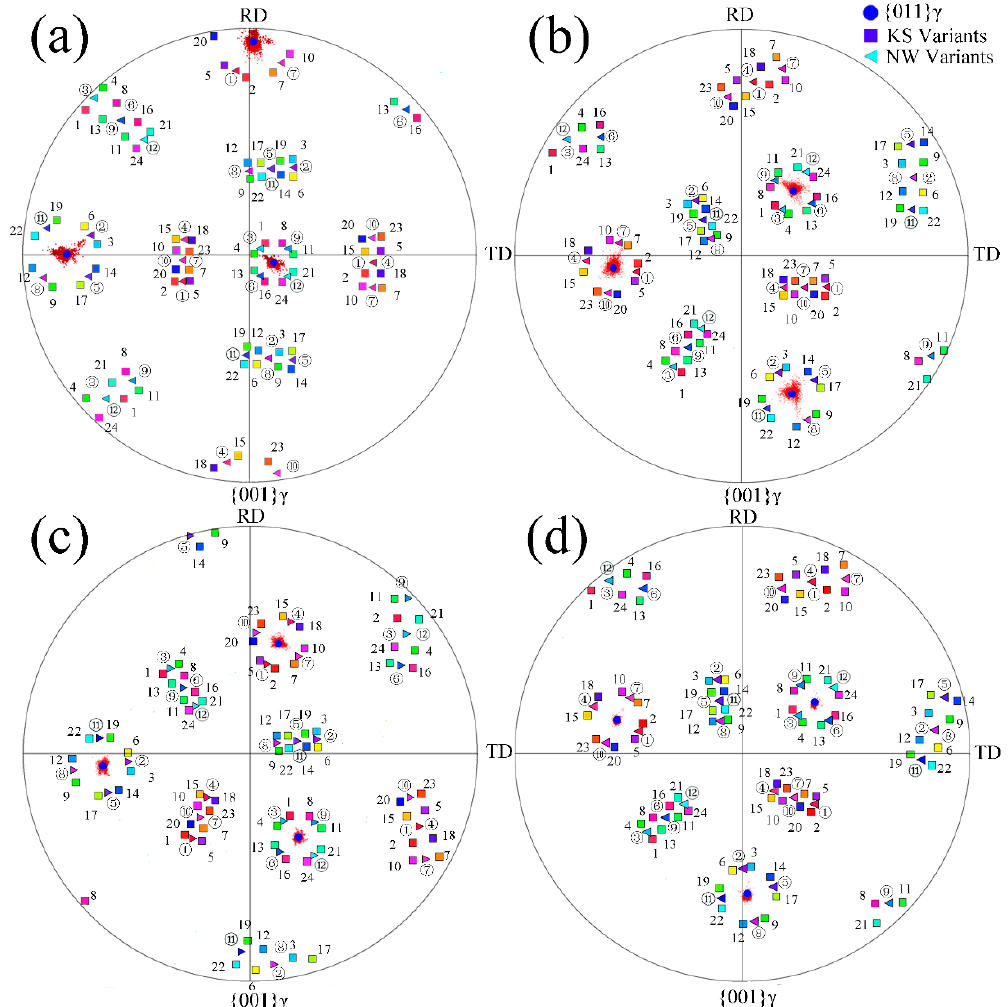
Figure 5. The {001} pole figures of the retained austenite in the ( a ) 200 °C; ( b ) 250 °C; ( c ) 300 °C and ( d ) 350 °C isothermal transformed microstructures, and the corresponding calculated K ‐ S (colored squares) and N ‐ W (colored triangles) variants of the bainitic ferrite.